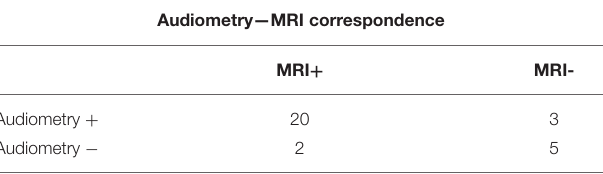
( Figure 1 ) ( p = 0.011, Cohen’s d = 0.876, BF10 = 5.328) (data already reported elsewhere)